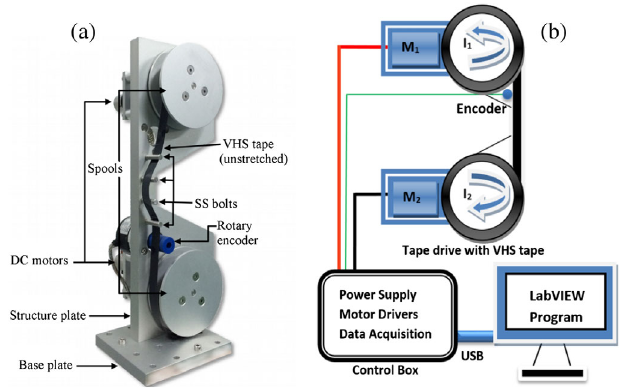
FIG. 2. Surface position reproducibility of the moving tape along the normal to the surface by imaging the thin side of the tape using CCD